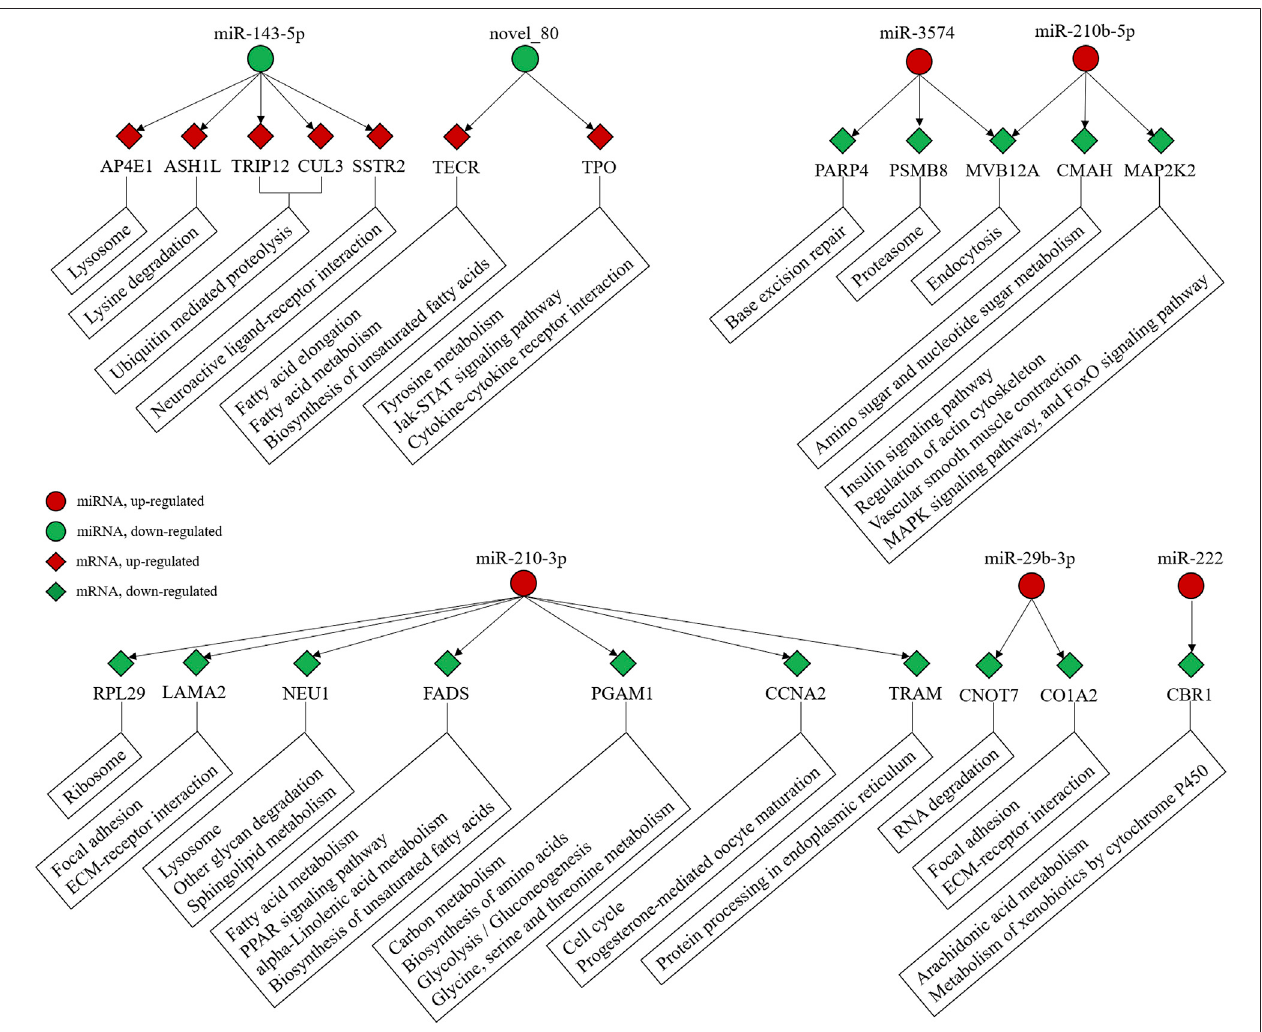
FIGURE 5 | Interaction between miRNA-mRNA and their relative